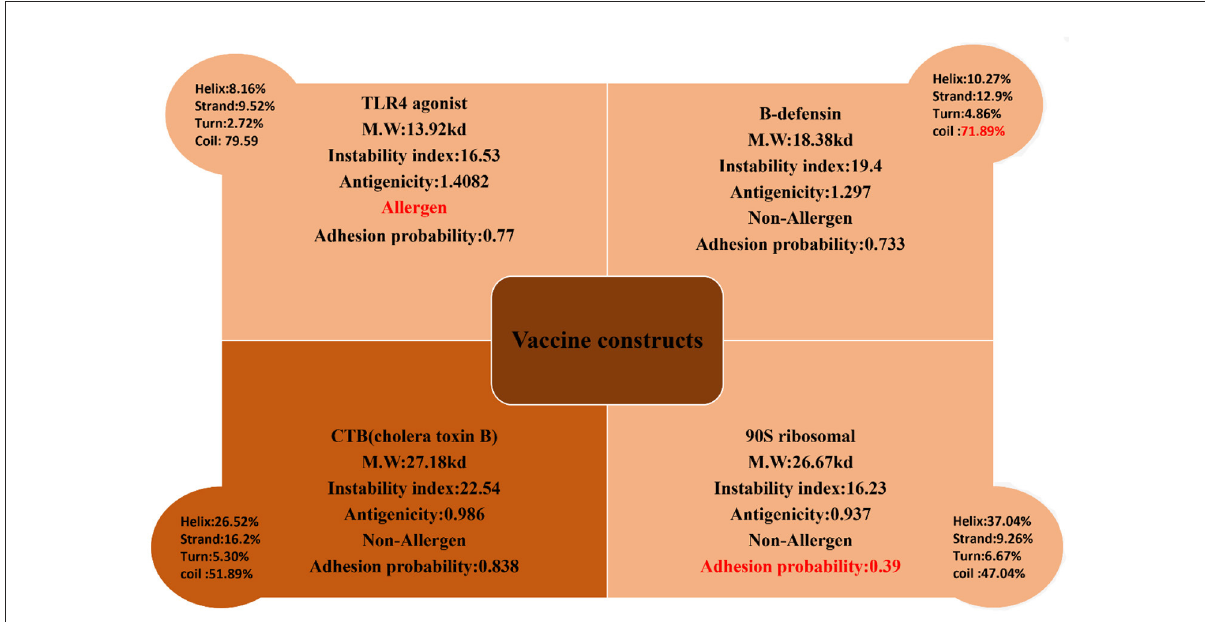
FIGURE5 Four constructs with different adjuvant were analyzed for their physiochemical properties and secondary structure parameters. One construct with a TLR4 agonist was an allergen, the construct with B-defensin had a higher number of coils depicting the unstable structure, and the construct with 90S ribosomal had a very low adhesion probability; these were discarded. The construct with CTB met the criteria of a potential vaccine.